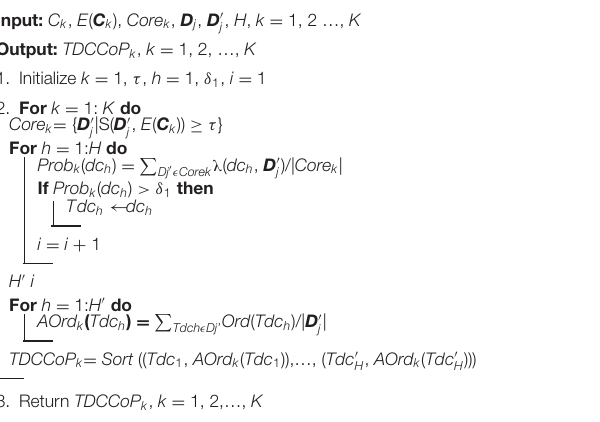
Algorithm 3 | TDCCoP extraction